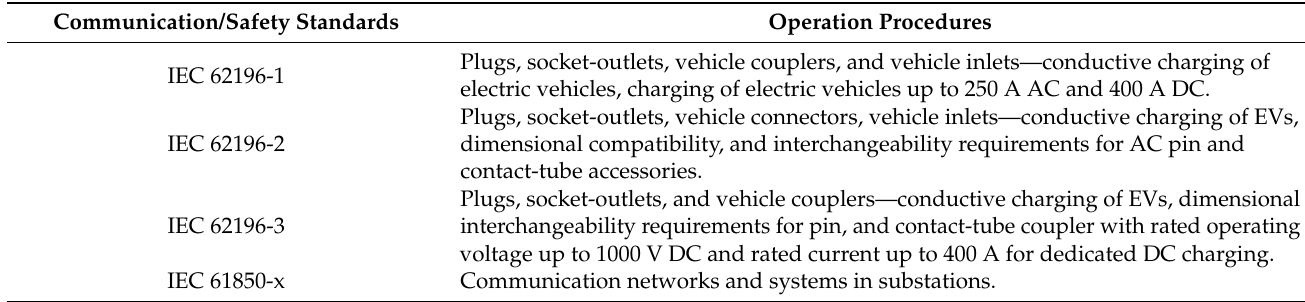
Table 3. Communication/safety standards associated with V2G technology